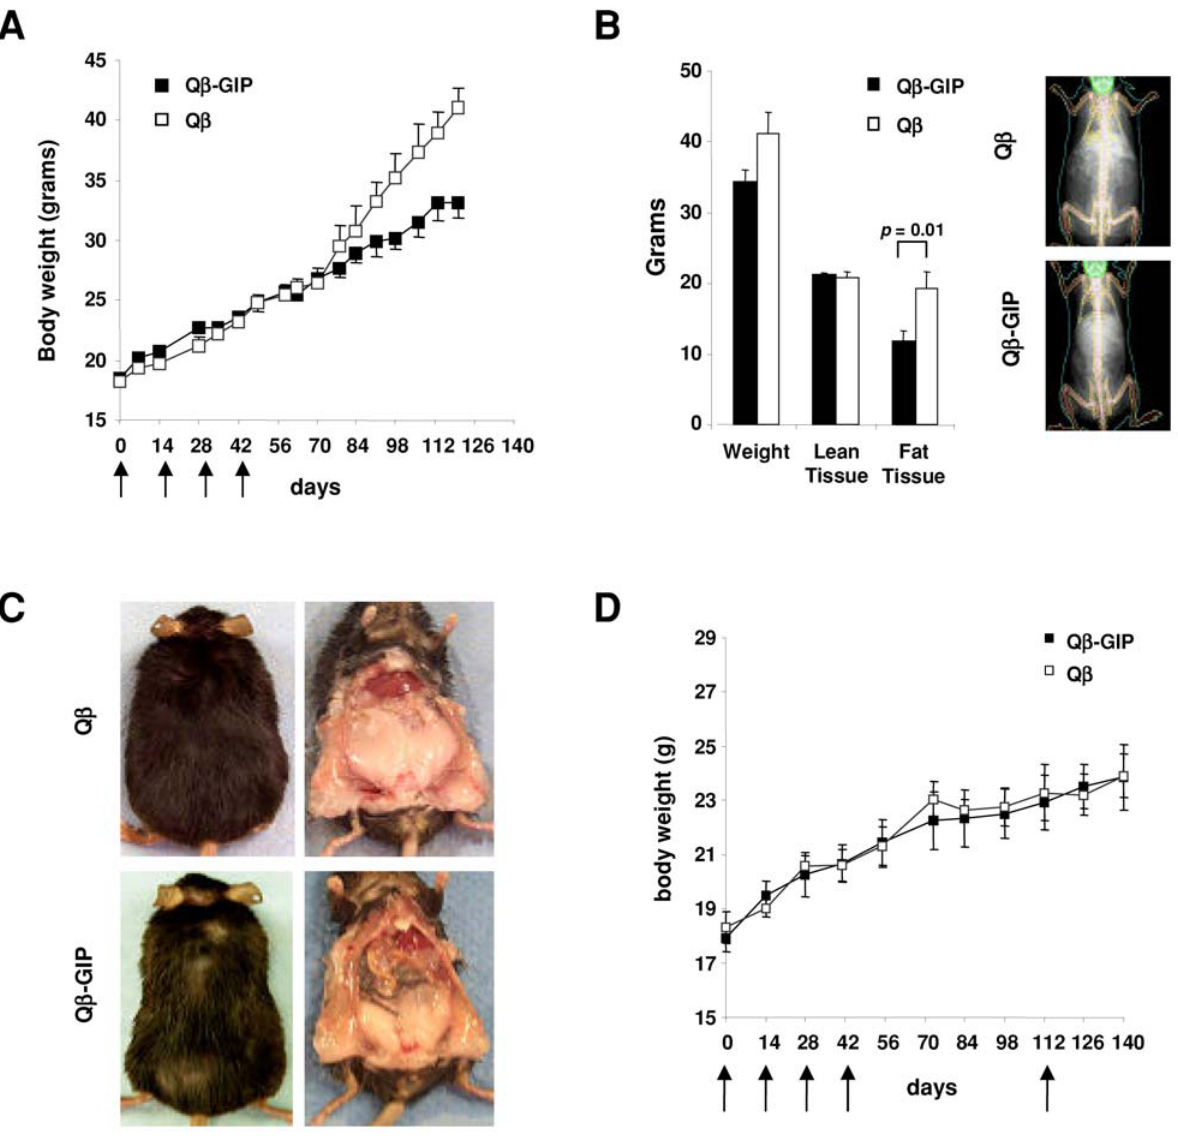
Figure 2. Vaccination against GIP protects against diet-induced obesity. (A) Body weight gain in immunized mice. Female mice were immunized (days 0, 14, 28, 42 and 133) with 100 m g of Q b -GIP or Q b VLPs and placed on a high fat diet (35% fat w/v). The average body weight + / 2 SEM (n=6) is shown. Body weight gain was was significanty reduced in Q b -GIP- compared to Q b VLP-immunized animals from day 70 onwards (two way ANOVA F(1,80)=18.55, p , 0.0001). (B) Body composition of mice shown in (A) was measured by DEXAscan on day 142. Average total body mass, lean and fat tissue mass + / 2 SEM (n=6) are shown. A significant reduction in fat content ( p =0.01) was observed between the Q b -GIP- and Q b - vaccinated group as determined by t-test. DEXAscan images of one representative animal per group are shown. (C) Macroscopic analysis of mice after 142 days of treatment with Q b -GIP or Q b VLPs. A representative mouse from each group from the experiment described in Figure 3A–B is shown. (D) Body weight gain in immunized mice on a standard rodent diet. Female mice were immunized (days 0, 14, 28, 42 and 112) with Q b -GIP or Q b VLPs and fed a standard diet (4% fat w/v) during the whole experiment. Average body weights + / 2 SEM (n=5) are shown. No significant difference between the two experimental groups was observed as determined (two way ANOVA F(1/88)=0.81,